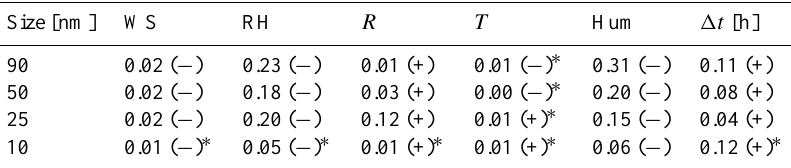
Table 2. Correlation between wind speed (WS), relative humidity (RH), global radiation ( R ), temperature ( T ), absolute humidity of the air (Hum) and trajectory travel time from the ocean ( 1t ), and hygroscopic growth factors of 90, 50, 25 and 10nm particles presented with calculated linear regression coefficient ( R 2 ) values. The 1 t values were calculated only for the trajectories which had been in connection with the ocean during the past five days. In brackets it is marked if the correlation is positive (+) or negative ( − ). An ∗ marks those correlations which were found to be statistically not significant (p-value >